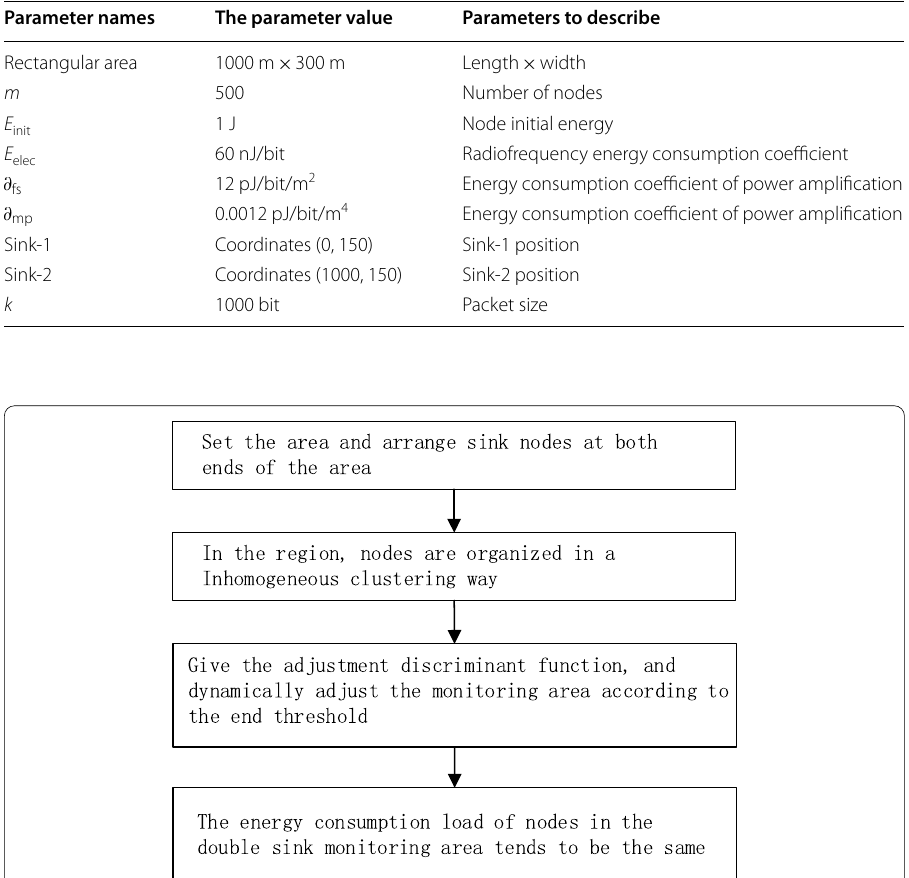
Table 1 Simulation experiment parameters table